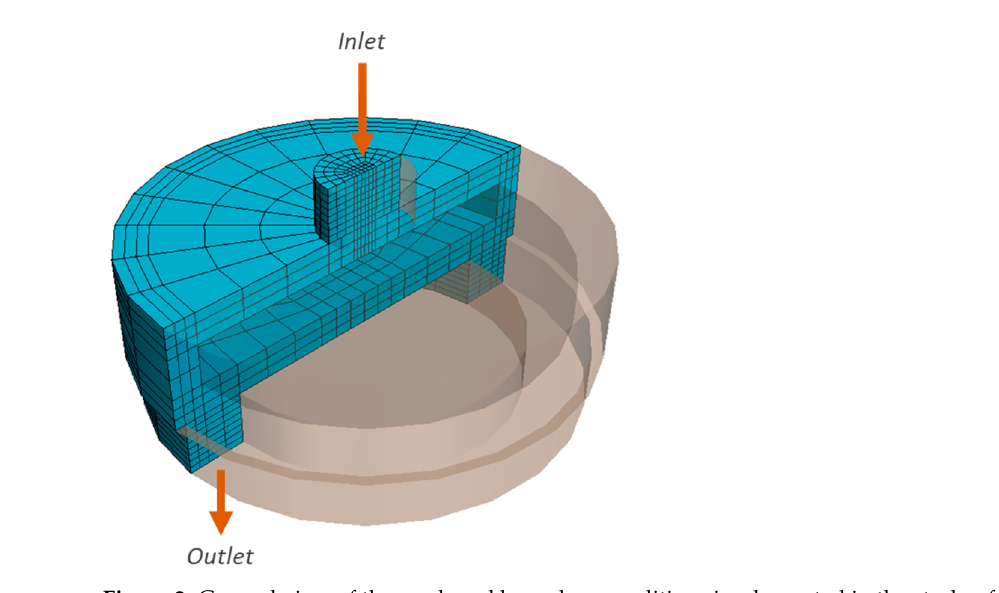
Figure 2. General view of the mesh and boundary conditions implemented in the study of the RCP.